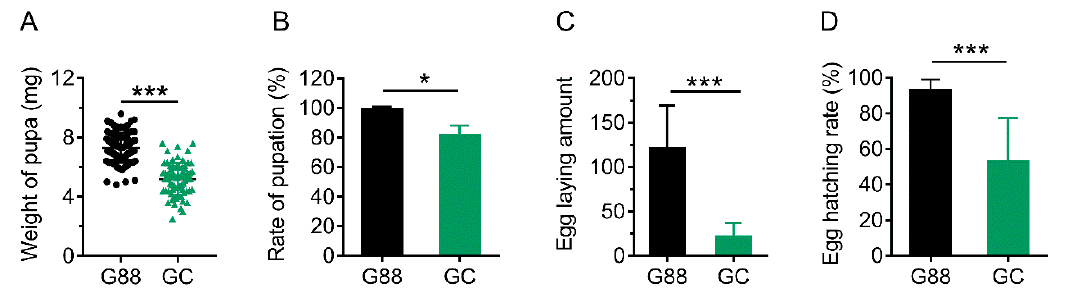
Figure 6. Comparison of performance between G88 and GC strains. ( A ) and ( B ). Weight of pupa ( A ) and pupation rate ( B ). Data were presented as mean ± SD (Student’s t test, * p < 0.05, **** p < 0.0001). ( C ) and ( D ). Total number of eggs laid by single pair of male and female adults during the first three days ( C ) and hatching rate ( D ). Data were presented as mean ± SD (Student’s t test, **** p < 0.0001).